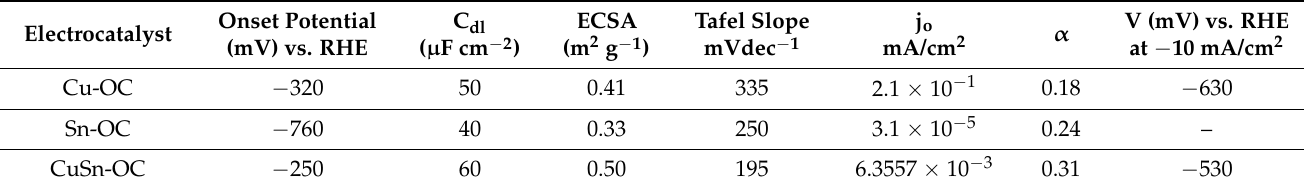
Table 3. HER performance of Cu-OC, Sn-OC, and CuSn-OC catalysts in 0.1 KOH alkaline solution. Electrocatalyst